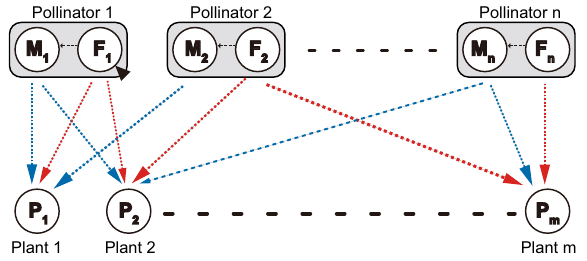
Figure 4. Conceptual illustration of a bipartite network model with m plant species and n pollinator